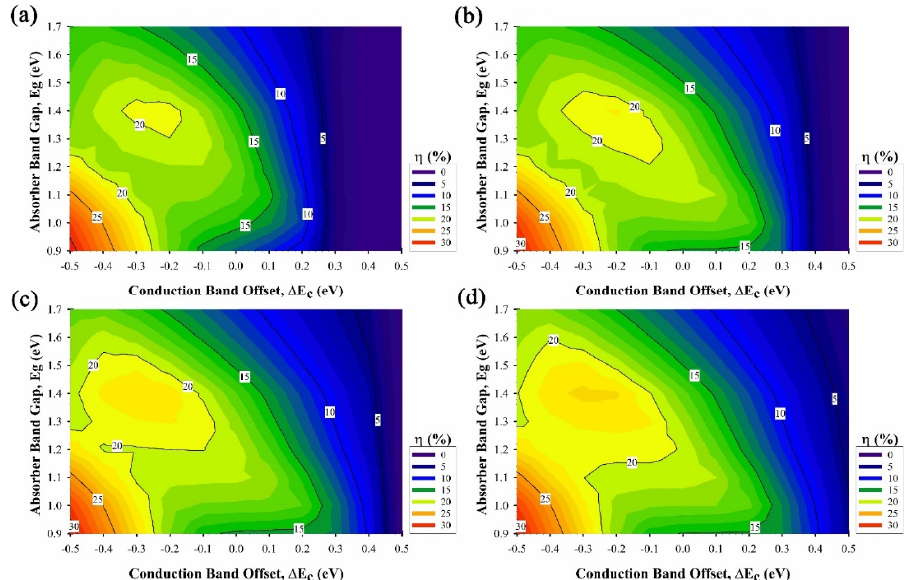
Figure 3. Effect of µ and N D of the CdS buffer layer on the conversion efficiency of thin film solar cell with an ideal absorber layer: ( a ) Set A: µ = 1 cm 2 /V·s and N D = 10 14 cm −3 , ( b ) Set B: µ = 100 cm 2 /V·s and N D = 10 14 cm −3 , ( c ) Set C: µ = 1 cm 2 /V·s and N D = 10 18 cm −3 , and ( d ) Set D: µ = 100 cm 2 /V·s and N D = 10 18 cm −3 .